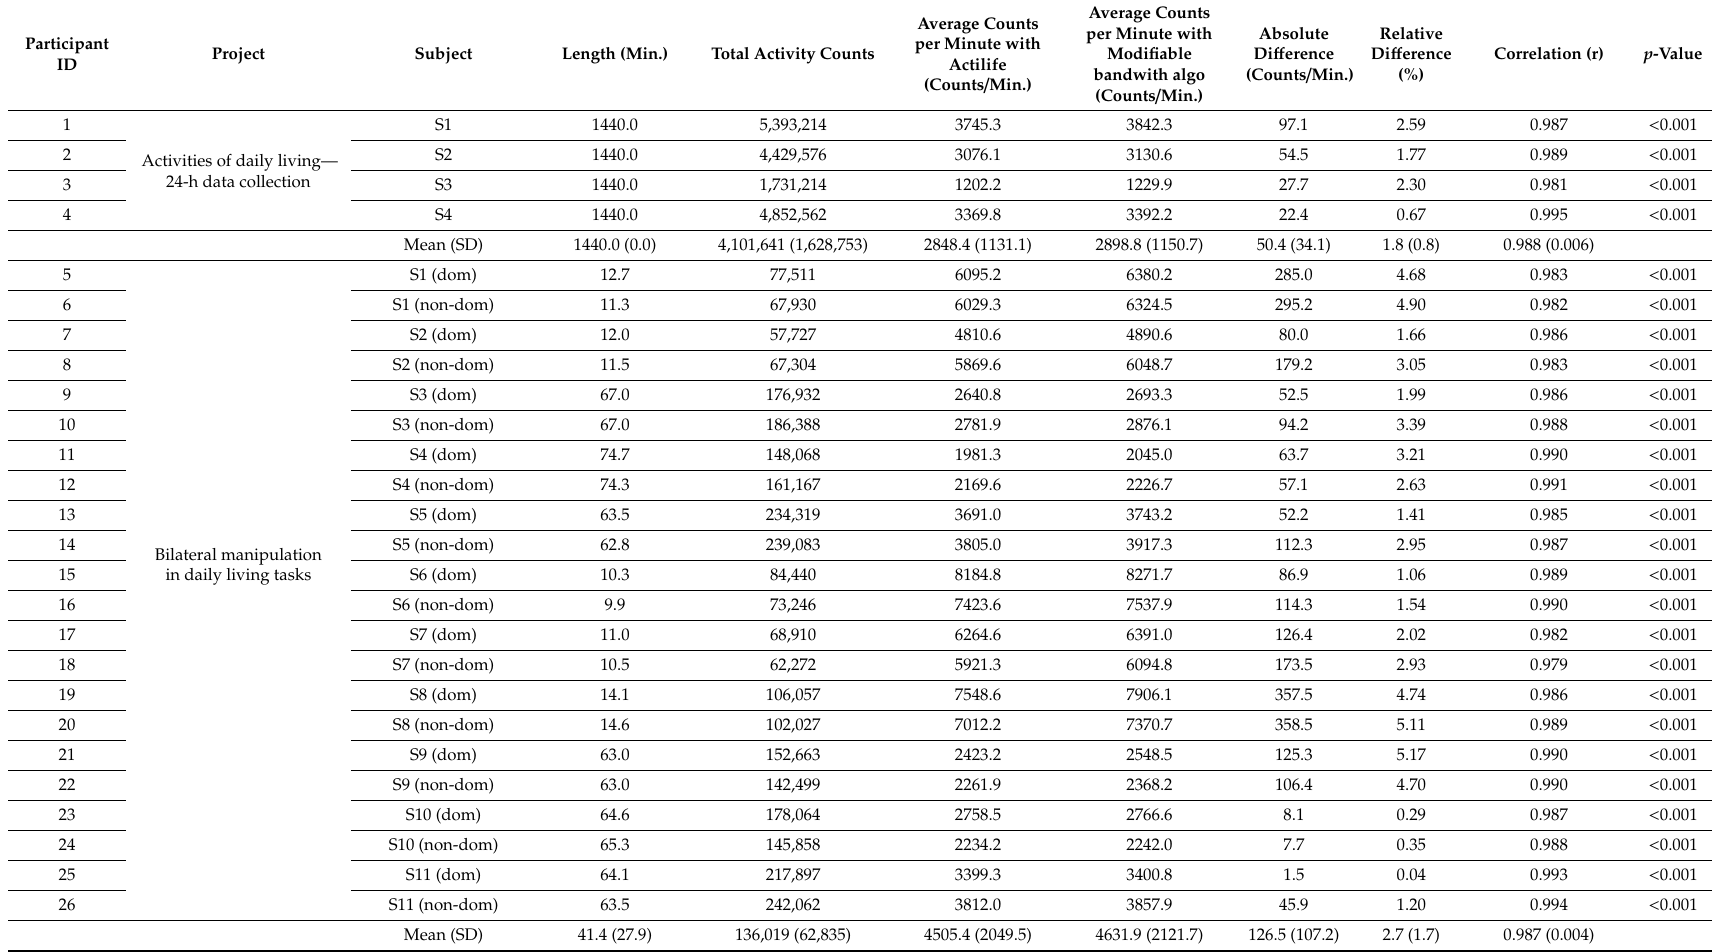
Table 3. Summary of data collection characteristics and comparison parameters between the modifiable bandwidth algorithm and the commercial